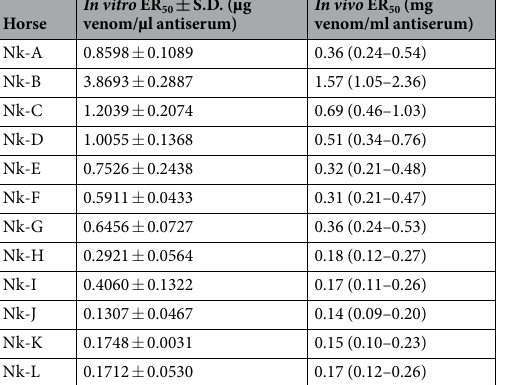
In vivo ER 50 (mg venom/ml antiserum)